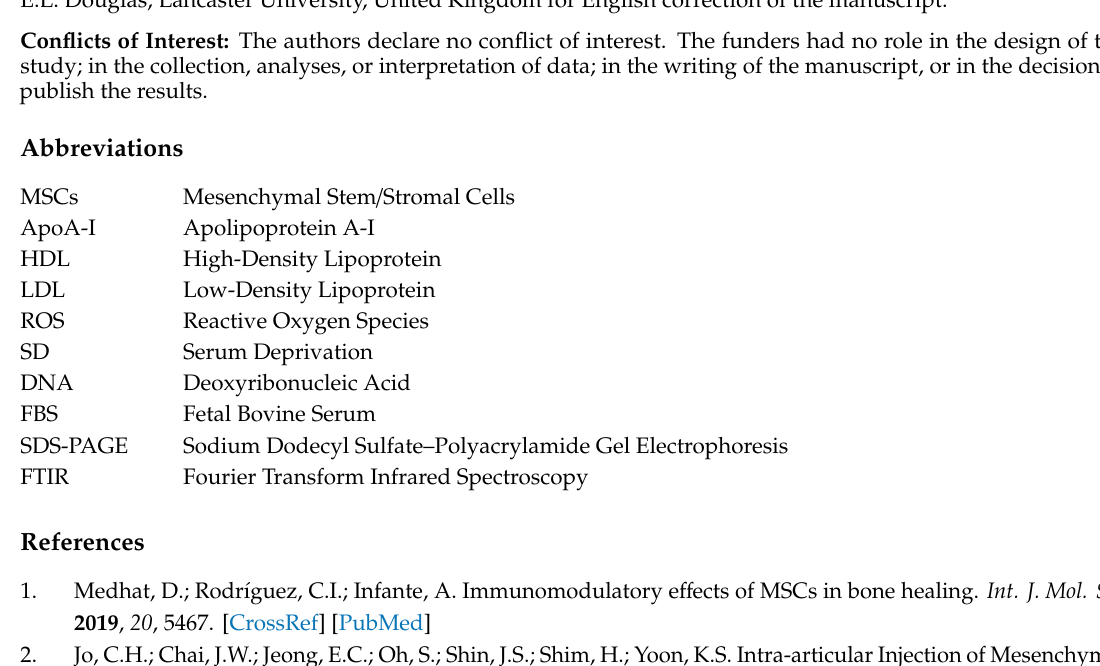
s1, Figure S1: Full 0.8% agarose gels electrophoregram illustrating the intracellular and secreted nuclease activity, Figure S2: Cell cycle of MSCs cultivated under SD and hypoxia conditions for 24 h (precondition) ( A ) followed by 3 h under normoxic condition ( B ) and 3 h normoxic condition with apoA-I ( C ), Figure S3: Cell cycle of MSCs cultivated under SD and hypoxia conditions for 24 h (precondition) followed by ( A ) 3 hours under normoxic condition with addition of H 2 O 2 100 µ M; ( B ) 3 h normoxic condition with addition of apoA-I and H 2 O 2 100 µ M ( B ) and ( C ) MSCs cultivated under SD and hypoxia conditions with apoA-I for 24 h followed by 3 h normoxic condition with addition of apoA-I and H 2 O 2 100 µ